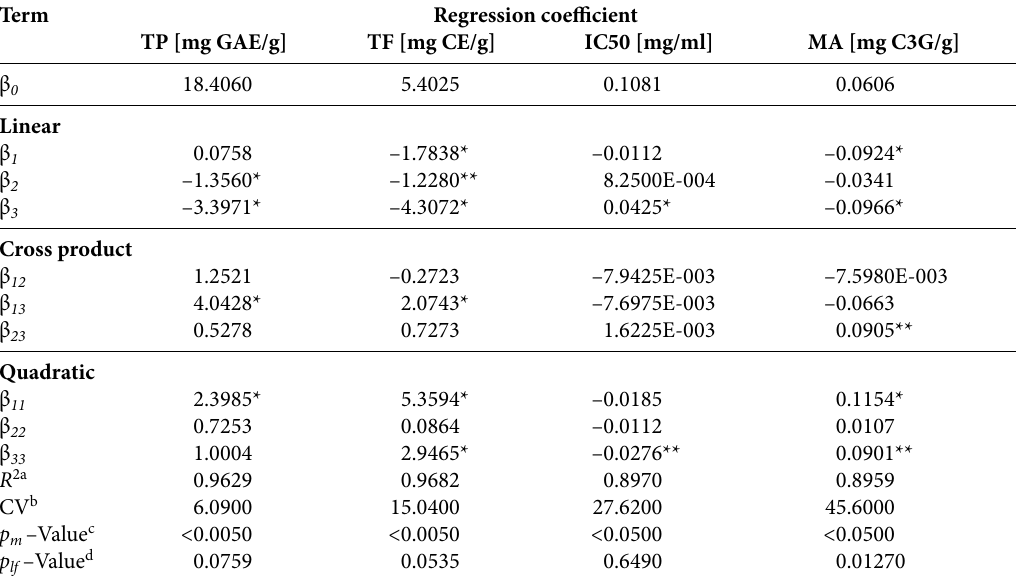
Table 3. Estimated coefficients of the fitted second-order polynomial model for TP, TF, IC50 and MA, and analysis of vari- ance (ANOVA) for the investigated systems